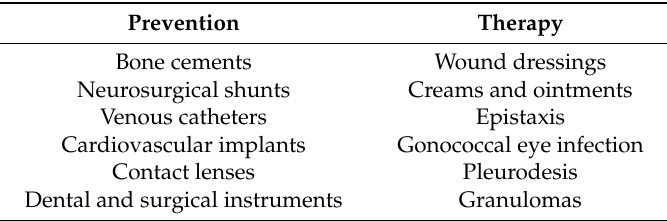
Table 3. Medical applications of nanosilver [43,44,52,53].